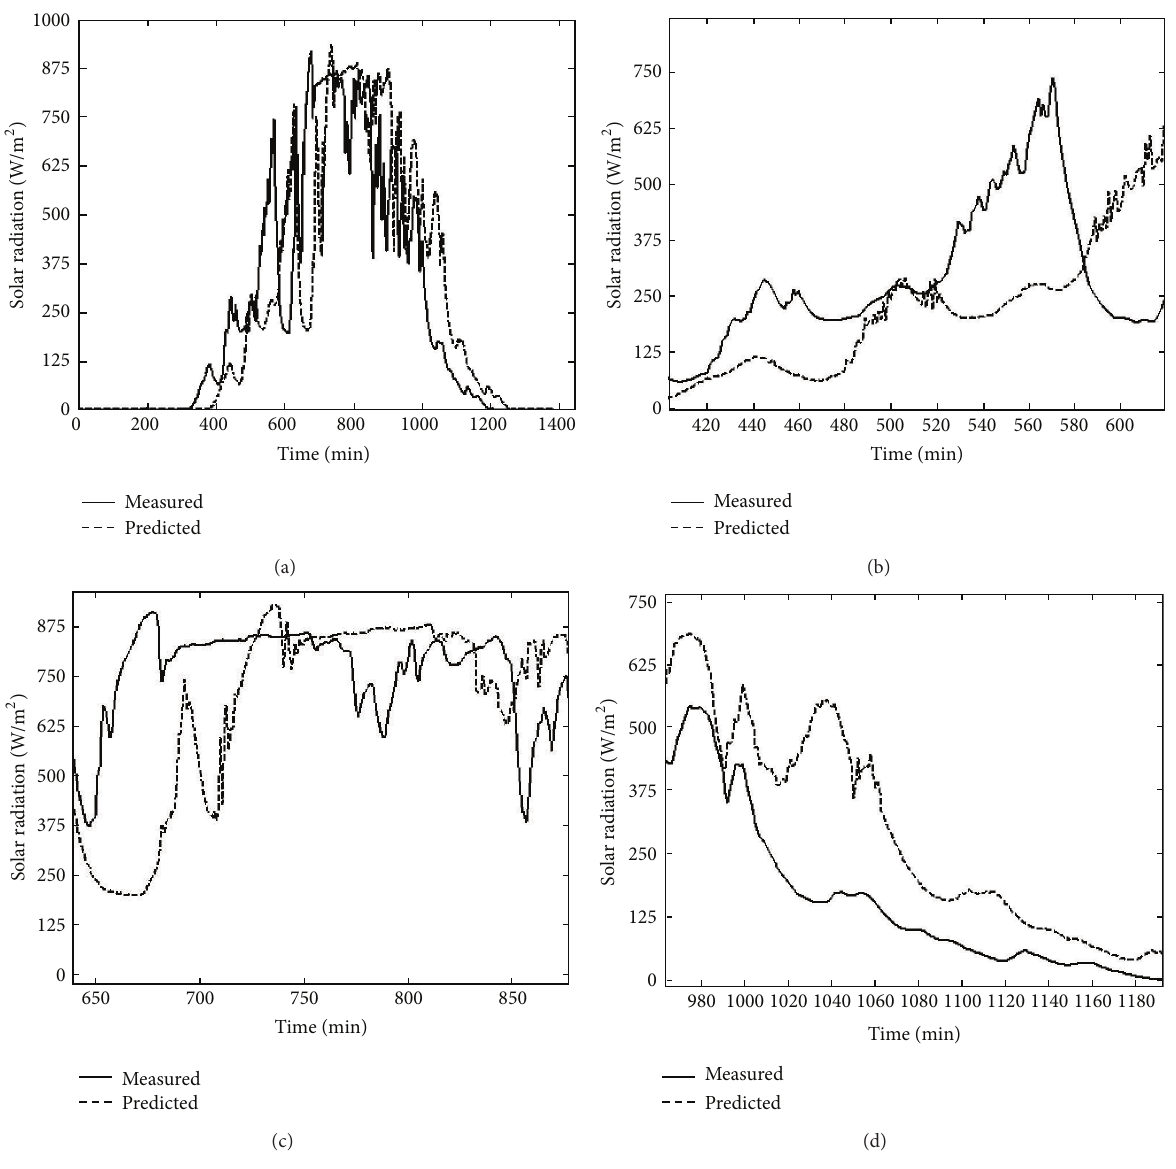
Figure 9: Sixty-step ahead solar radiation prediction for one day using a MARM with 𝑚 = 3 and 𝑝 = 4 . (b), (c), and (d) represent zooming images of (a).